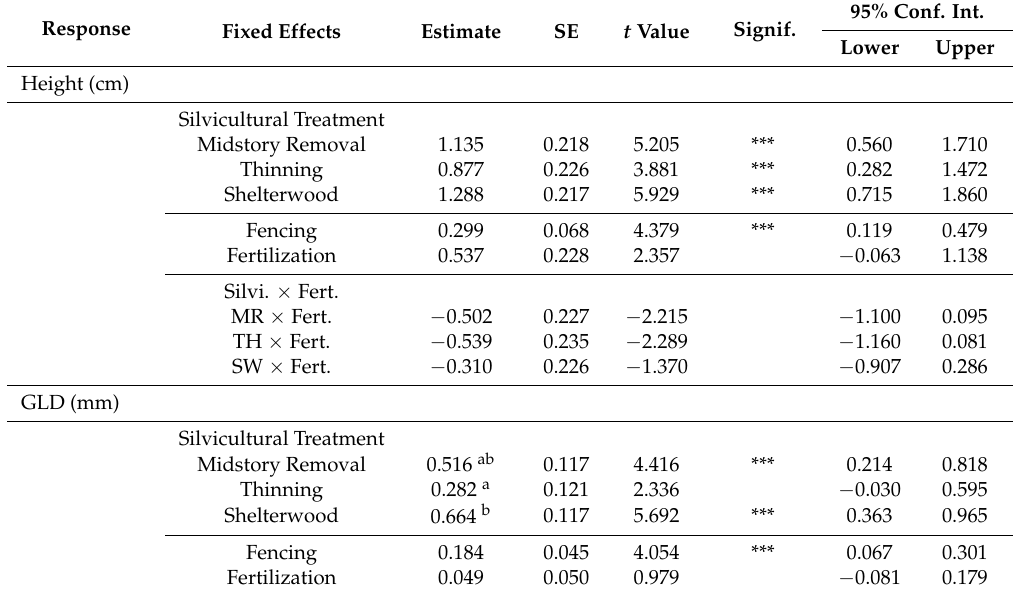
Table 4. Results of mixed-effects linear regression analyzing the effects of silvicultural treatments, fencing, and fertilization on 10-year height and ground line diameter (GLD) growth of underplanted northern red oak ( Quercus rubra L.) seedlings. Responses were transformed with natural log prior to